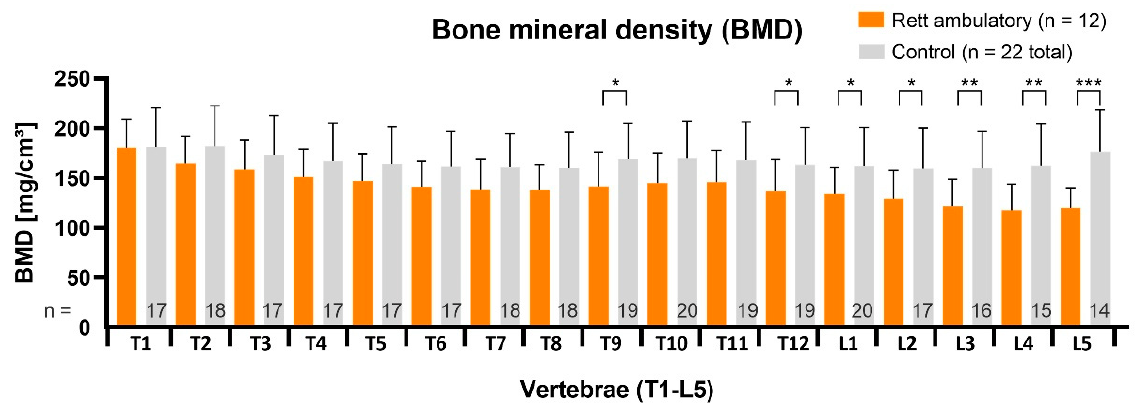
Figure 5. The vBMD comparison of ambulatory RTT patients (n = 12) to healthy controls. The average values show significant reduction in lumbar vertebrae. T = thoracic vertebra; L = lumbar vertebra. Statistical significance was defined as p < 0.05 (*), p < 0.01 (**) and as p < 0.001 (***).